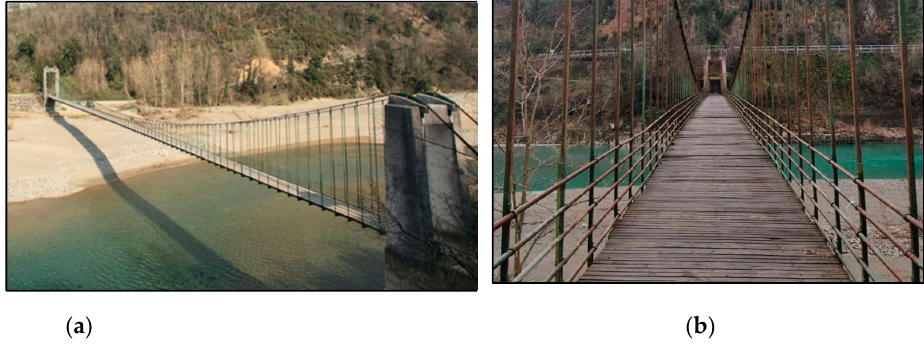
Figure 2. General views of the Ramello footbridge: (a) lateral view and (b) longitudinal view.